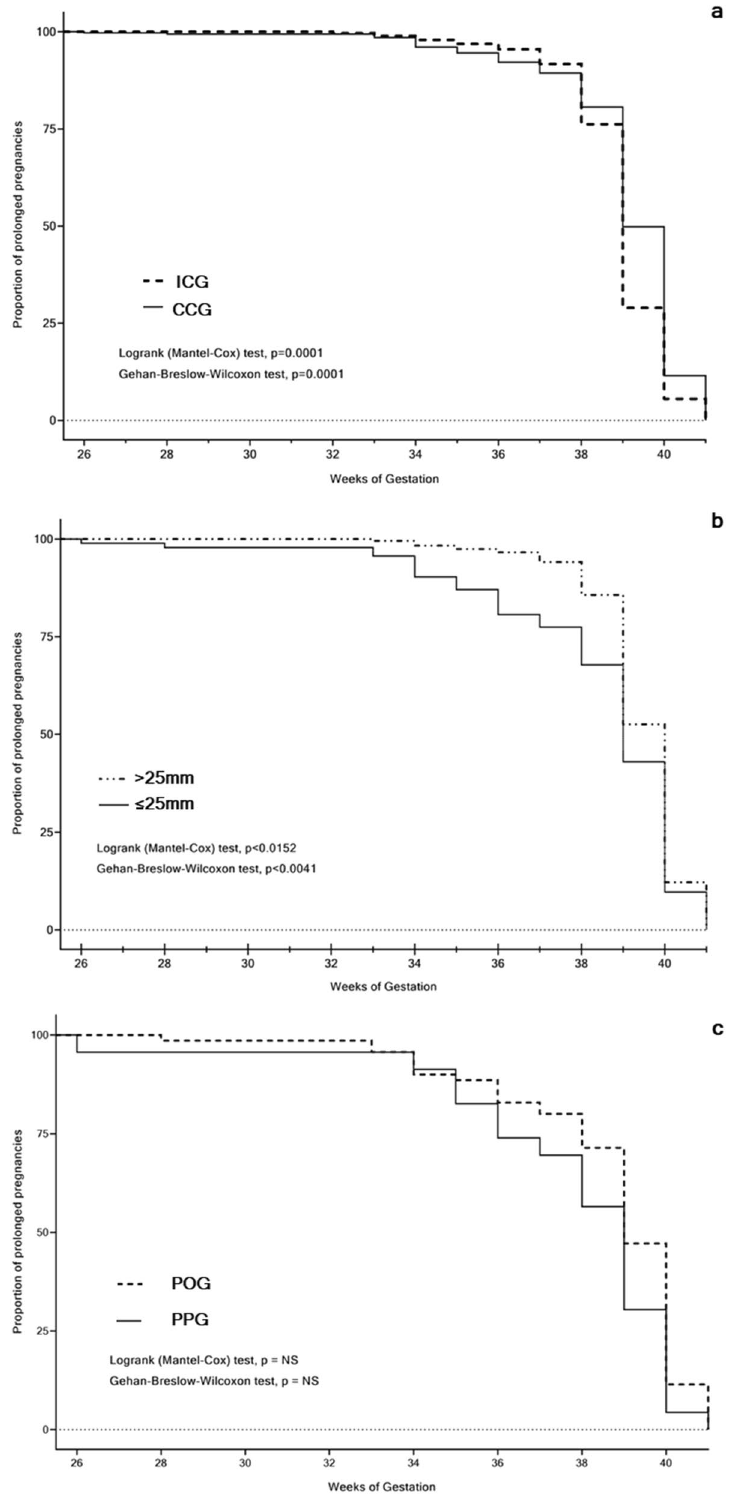
Figure 7. The pregnancy duration curve (unit: the proportion of prolonged pregnancies during 26–41 weeks) in asymptomatic women with singleton pregnancies: ( a ) Intact Cervix (ICG) vs. Cervical Conization (CCG), groups; ( b ) Adequate cervical length (CL > 25 mm) vs Short cervix (CL ≤ 25 mm), groups; ( c ) Progesterone-only (POG) vs Progesterone-Pessary (PPG),